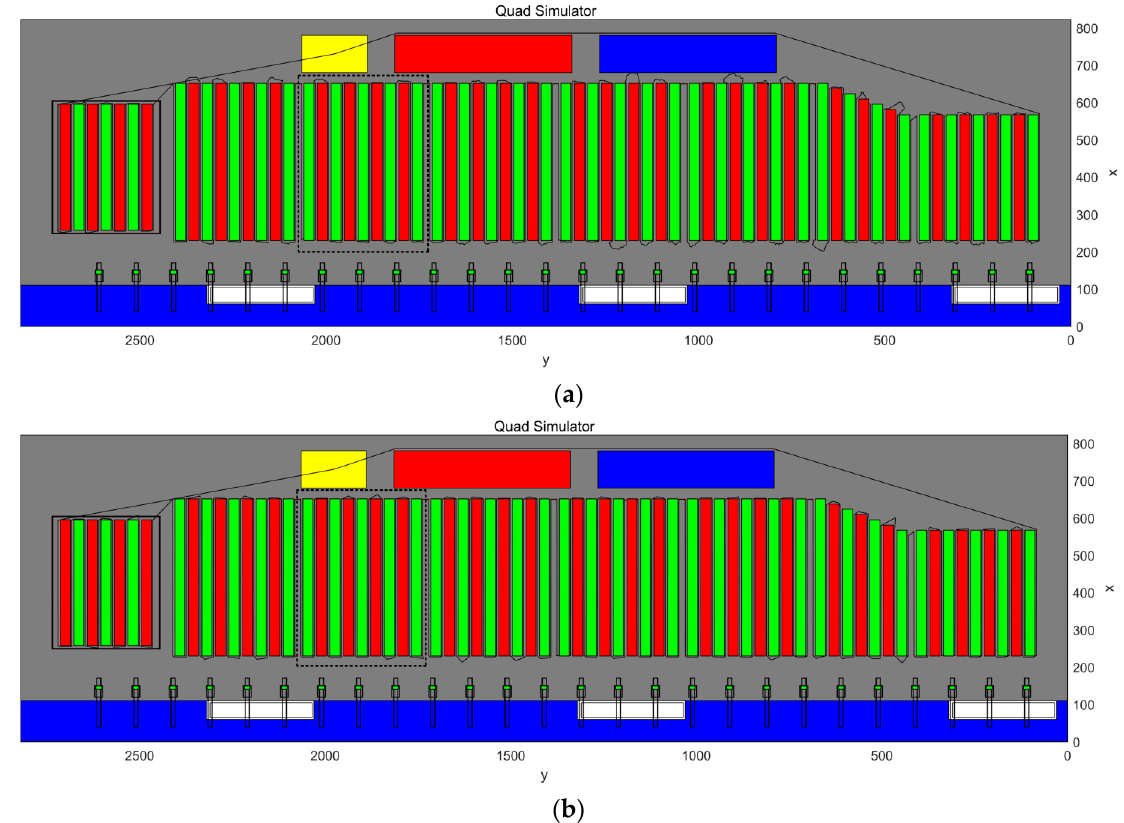
Figure 10. Detection paths generated by the algorithms in Scenario 2. ( a ) Path generated by the bias_RRT* algorithm. ( b ) Path generated by the improved bias_RRT* algorithm.